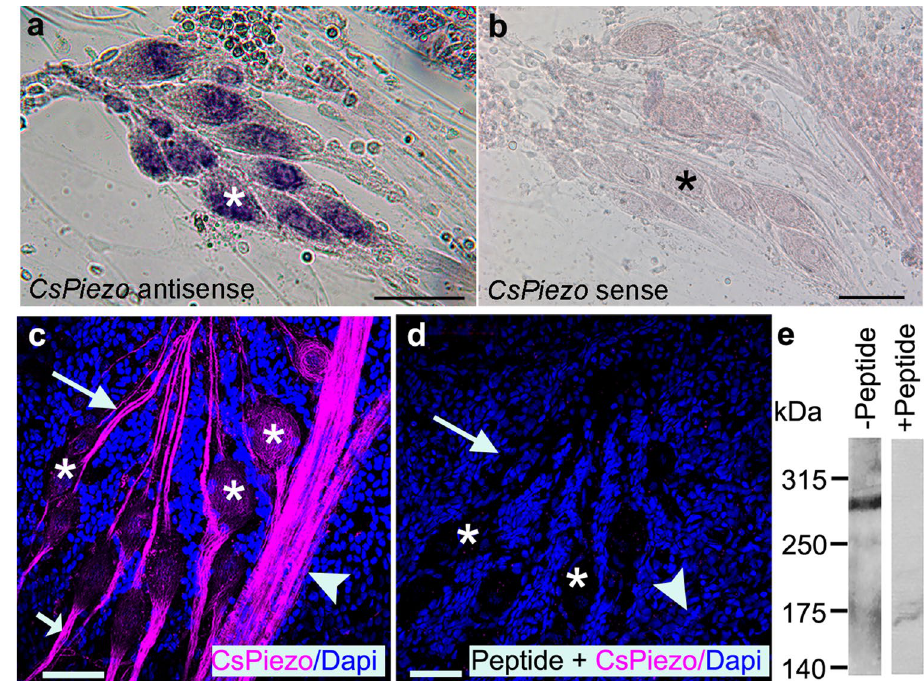
Figure 2. CsPiezo expression in C. salei VS-3 mechanosensory neurons. ( a ) In situ hybridization with a digoxigenin labeled antisense probe for CsPiezo mRNA produced strong signal in the mechanosensory VS-3 neuron somata ( one indicated with an asterisk ). ( b ) A sense (control) probe did not produce any labeling in VS-3 neurons or other cells of the patellar hypodermis. ( c ) A custom-made polyclonal antibody for CsPiezo protein ( magenta ) labeled VS-3 neuron dendrites ( large arrow ), axons ( small arrow ) and strong labeling was also present in the leg nerve ( arrowhead ). CsPiezo labeling in the central regions of the cell bodies ( asterisks ) was not as strong. Blue DAPI labeling shows the nuclei of many cells in the hypodermis. ( d ) The magenta labeling seen in the neurons in c was absent from control experiments where the CsPiezo antibody was incubated with an excess of the blocking peptide before the staining protocol. Arrow indicates the VS-3 dendrites, asterisks show some of the cell bodies and the arrowhead points to the leg nerve. DAPI staining is visible in many cells of the hypodermis. ( e ) The CsPiezo antibody produced a specific band at 295 kDa, the molecular weight of the CsPiezo protein. This band was not present in the control experiment where the primary antibody was preincubated with the blocking peptide (+ peptide) before the experiment. Scale bars in a-d are 50